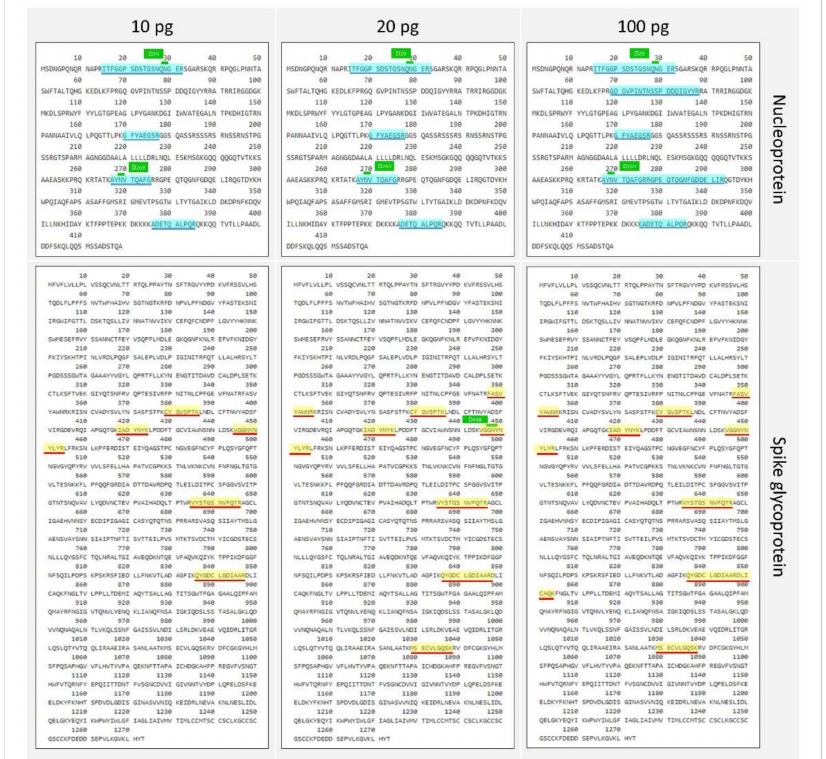
Figure 4. Sequence coverage of the nucleoprotein and the spike glycoprotein analyzing purified SARS- CoV-2 proteins. Peptides identified for the nucleoprotein in blue ( above ) and the spike glycoprotein in yellow ( below ) analyzing 10 pg, 20 pg and 100 pg of each purified SARS-CoV-2 protein (S1, S2, RBD and N). Possible sites of N-glycosylation are identified with letter D (in green) with the related position in the AA